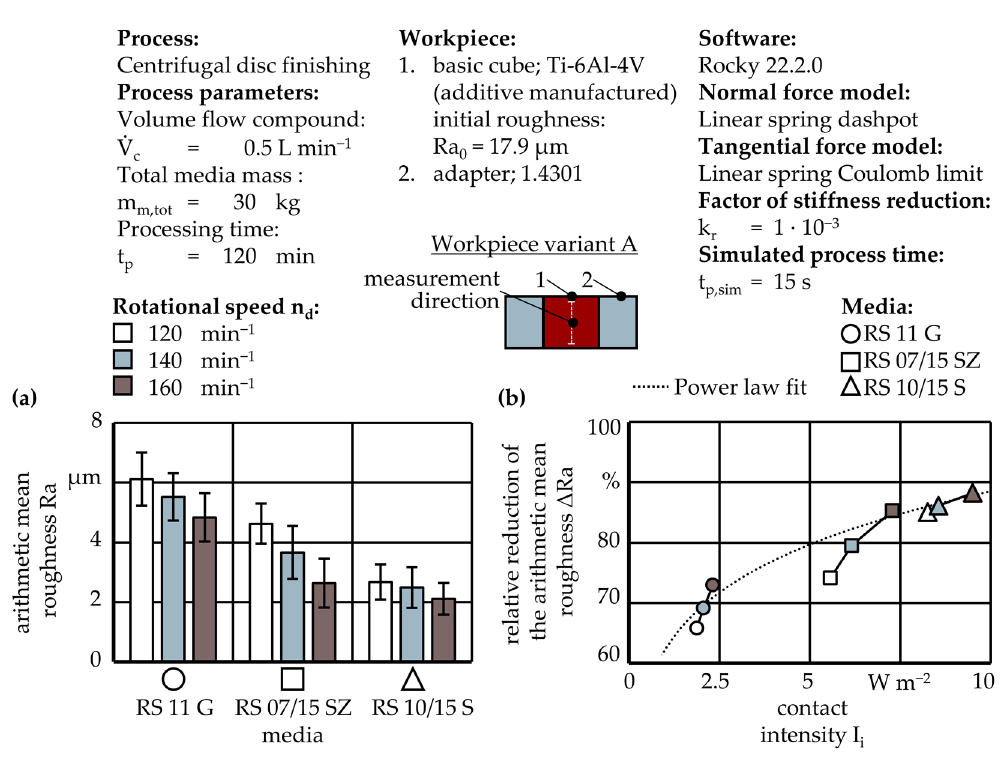
Figure 9. Workpiece variant A: ( a ) results of finishing experiments; ( b ) correlation between experi- mental and simulated results.